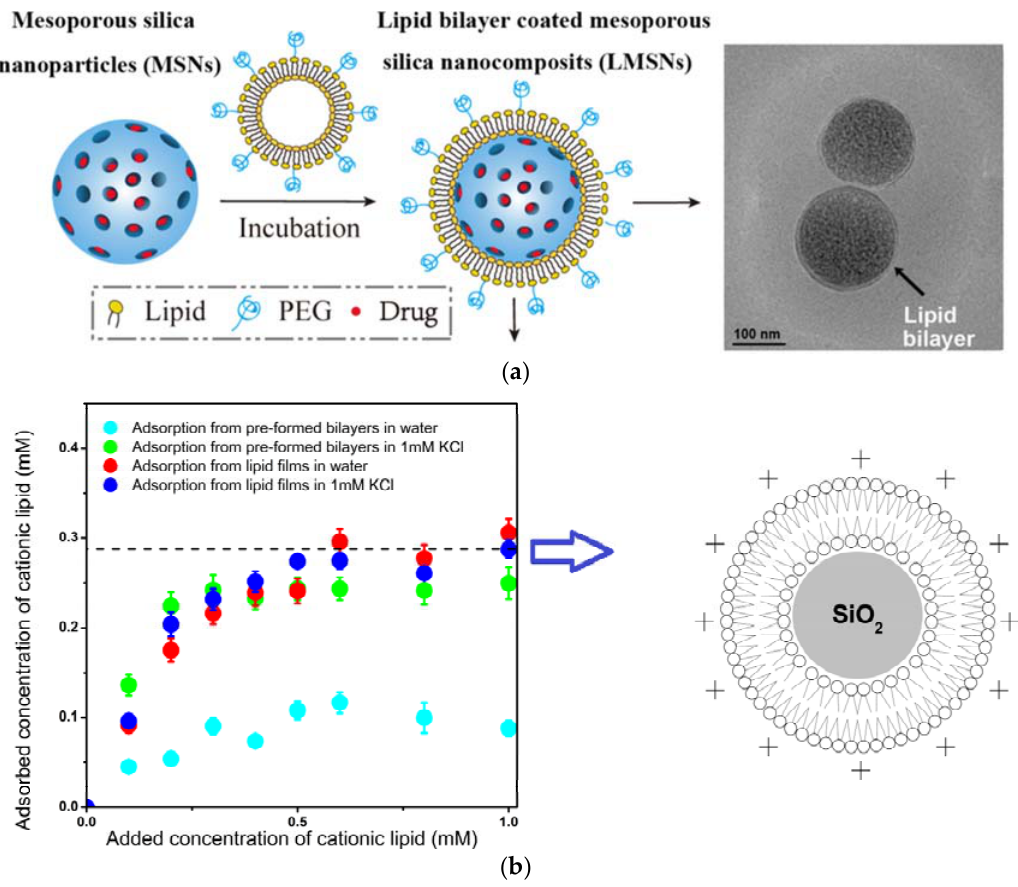
Figure 4. ( a ) Mesoporous silica particles as drug carriers with adsorbed phospholipid and pegylated ‐ phospholipid bilayer as reproduced from [90]; reprinted from reference [90].